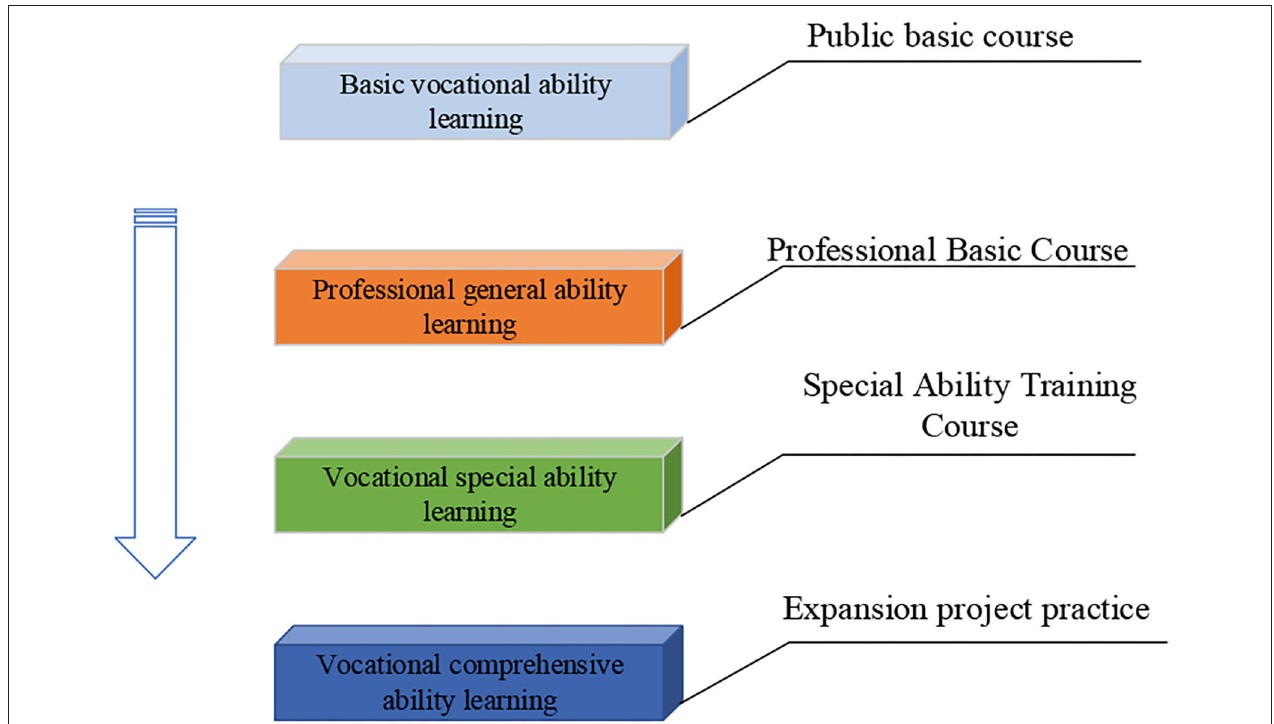
FIGURE 1 | College entrepreneurship and innovation course based on hierarchical